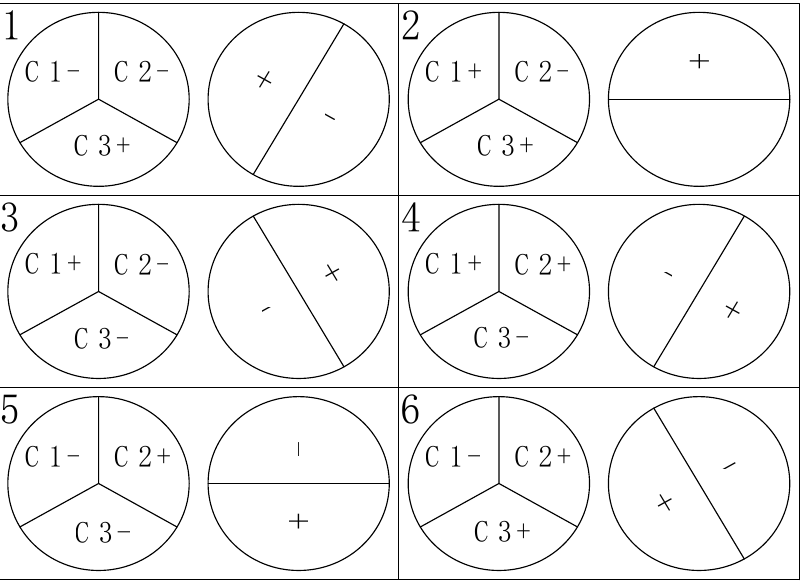
Figure 2. Magnetic sequences for rotation clockwise of the motor. The magnetic polarity of the C1, C2 and C3 coils along twelve continuous